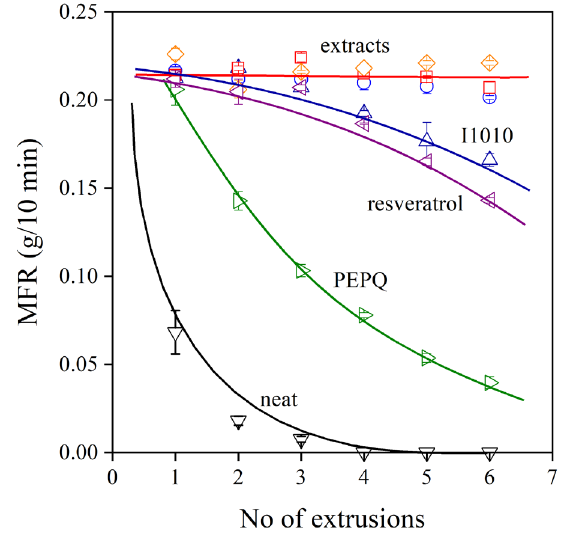
Figure 7. Effect of processing history (number of extrusions) on the viscosity (melt flow rate) of polyethylene processed in the presence of various additive packages. Symbols are the same as in Figure 6.